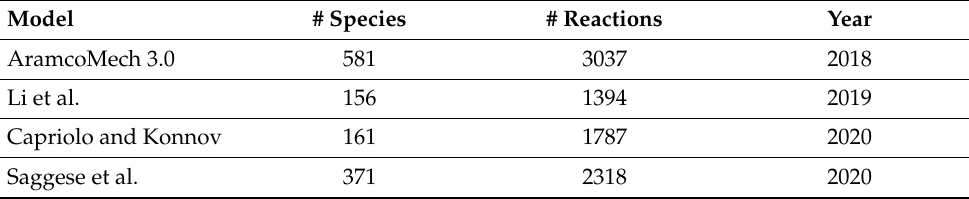
Table 2. Characteristics of the four chemical kinetic models used for comparison with experiments.